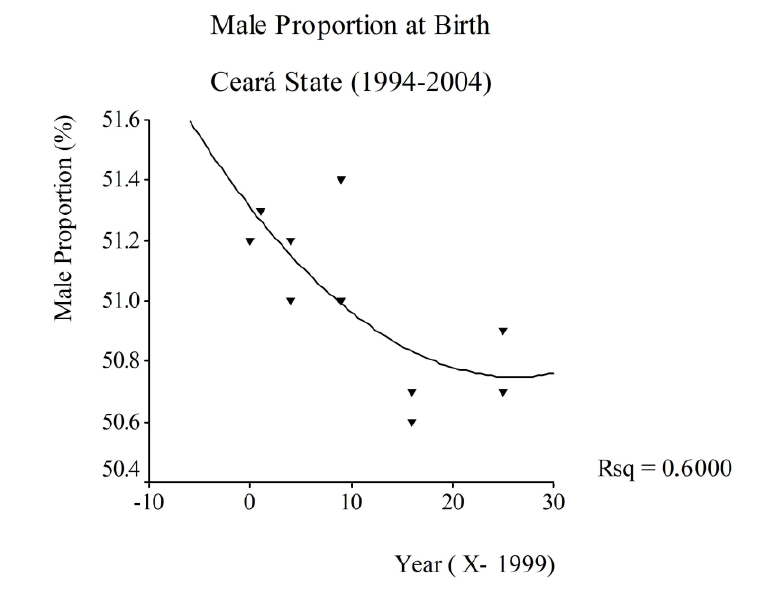
Figure 3. Time trend of male proportion at birth, Brazil, Ceara State, 1994-2004.